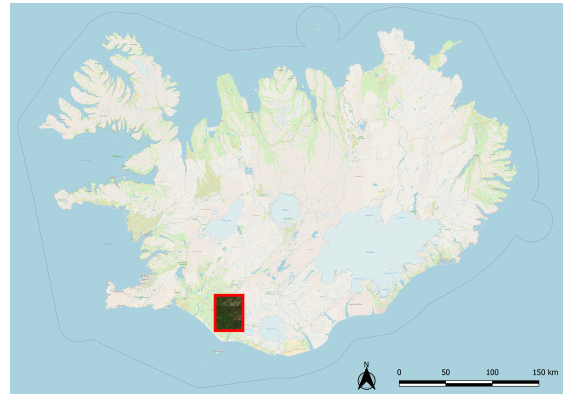
Figure 1. Georeferenced location of selected patch. found very little variation in overall model performance across all our cross-validation runs. The average accuracy achieved across the runs was 0 . 907 with a standard deviation of 0 . 001 . The F1 scores for each soil erosion class ranged from 0 . 88 to 0 . 93 , recall ranged from 0 . 86 to 0 . 95 and precision ranged from 0 . 89 to 0 . 92 , indicating a very accurate model.